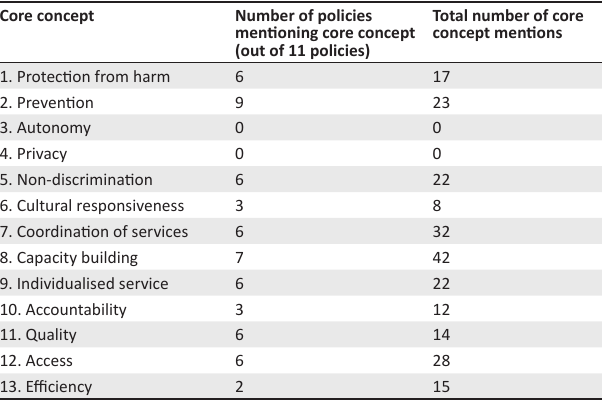
TABLE 4: Number of core concepts mentioned in 11 regional policies (ranked by total number of CC